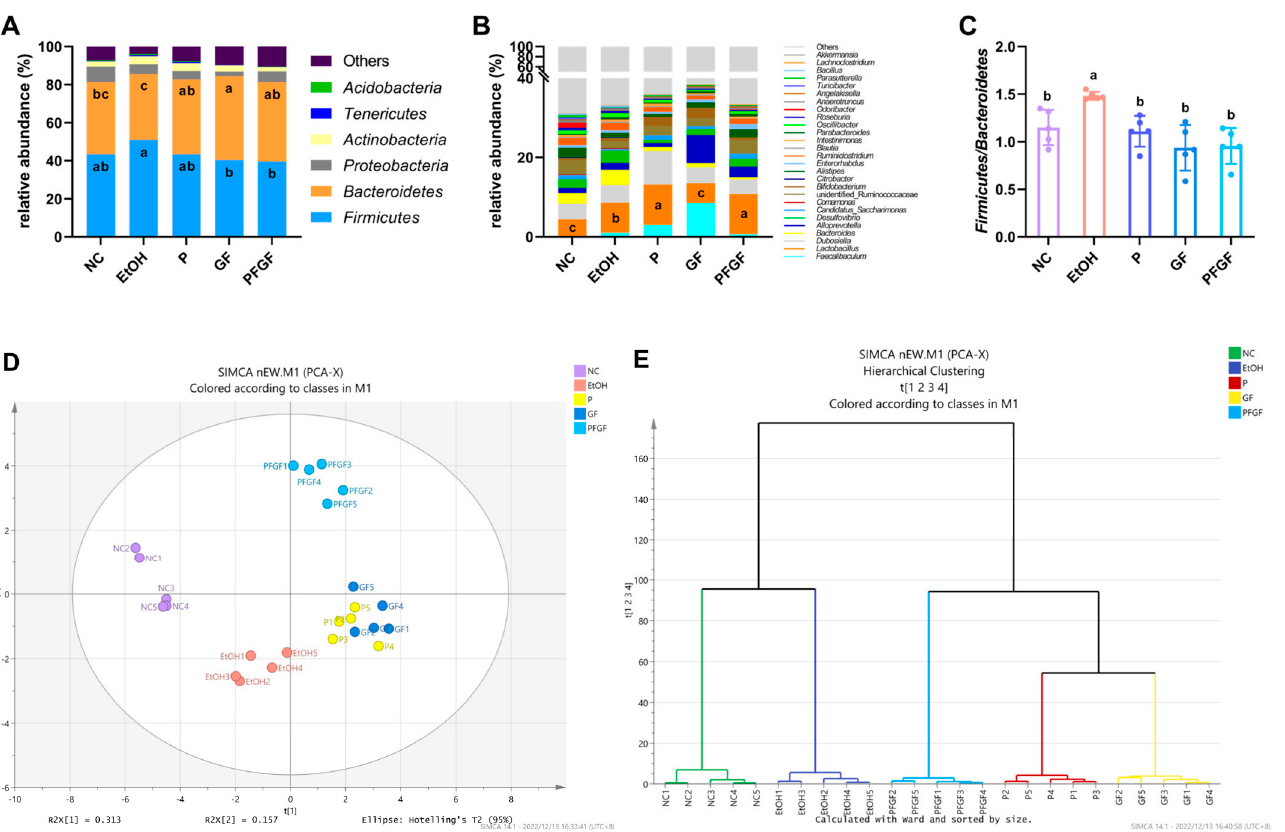
Figure 4. Components of intestinal microbiota at phylum ( A ) and genus ( B ) levels; value of relative abundance of Firmicutes / Bacteroides ( C ); PCA score ( D ); hierarchical clustering; ( E ) plots of intestinal microbiota at genus level in different groups. Different superscript letters indicate statistically significant differences between groups ( p < 0.05).